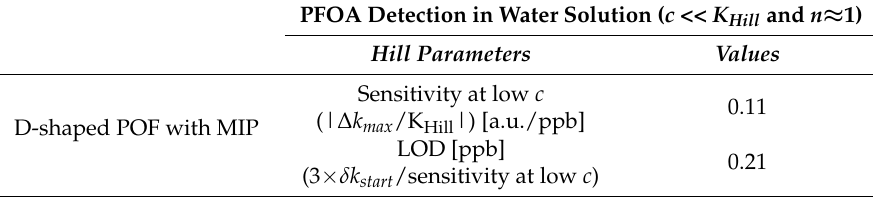
Table 3. Chemical parameters (D-shaped POF-MIP